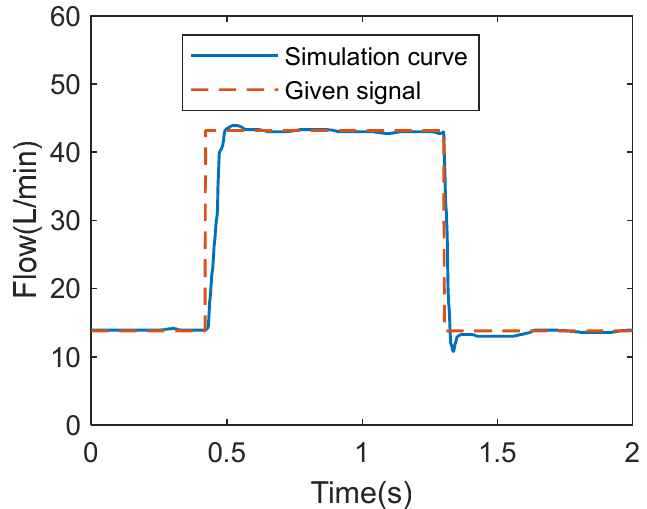
Figure 4. Square-wave signal for flow control.